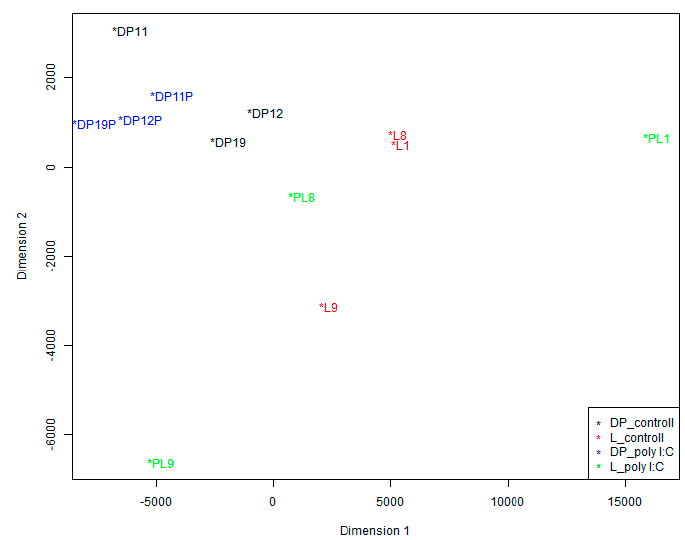
Figure 3. Multidimensional Scaling (MDS) analysis of the control and poly I:C stimulated samples using expression of all miRNAs. Black, red, blue and green dots mean samples of DP_controll, L_controll, DP_poly I:C, and L_poly I:C, respectively.